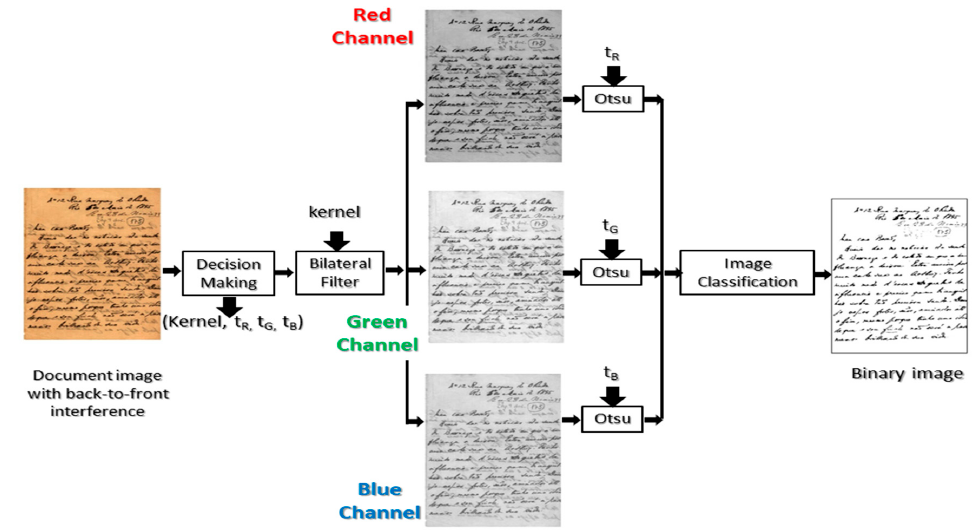
Figure 2. Block diagram of the proposed algorithm.